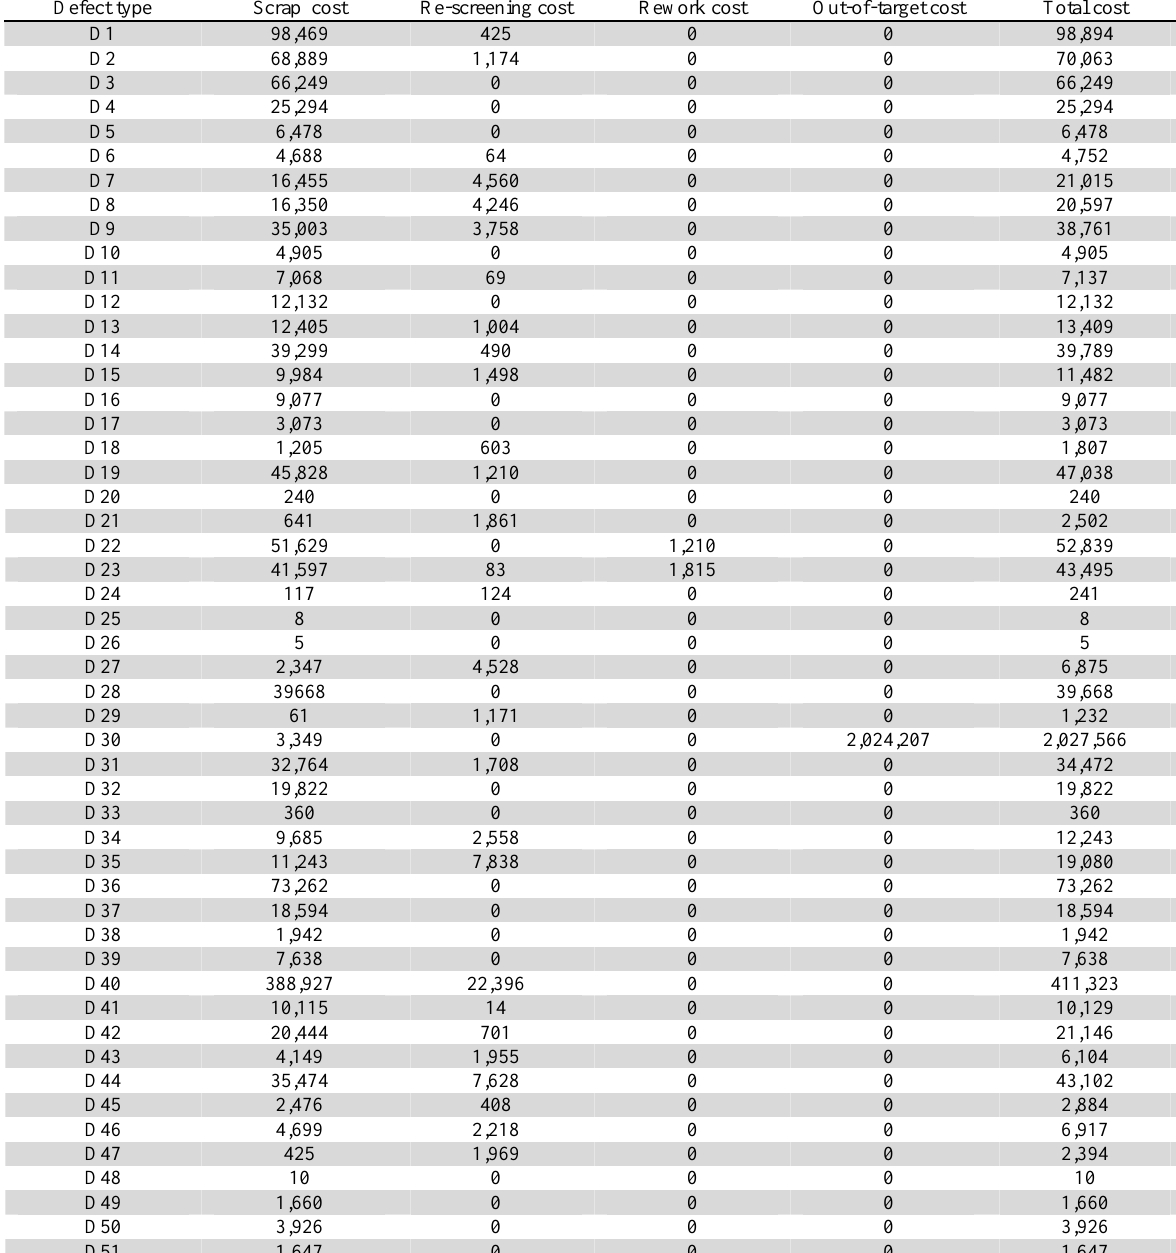
Failure costs of final product parameters Defect